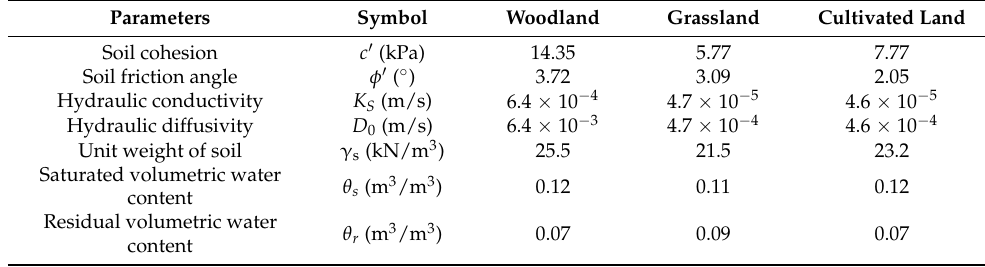
Table 1. Input parameters of the TRIGRS model.